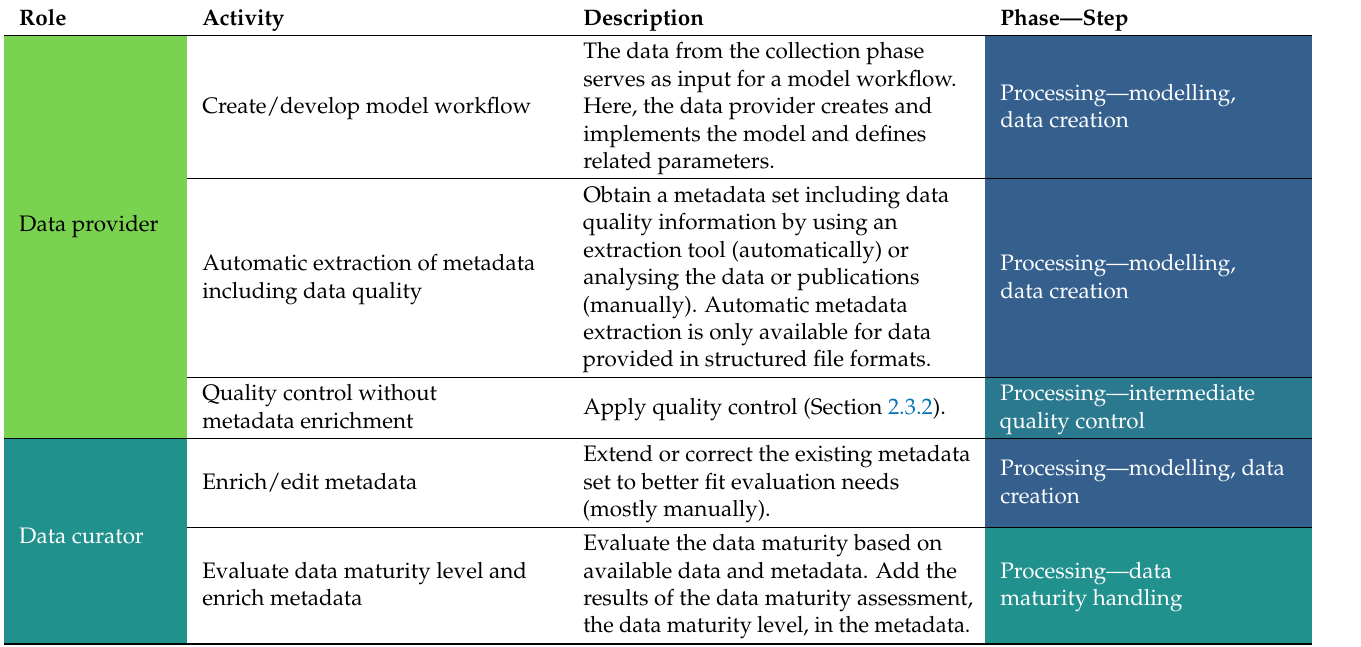
Table 11. Roles and their activities with descriptions at processing phase.